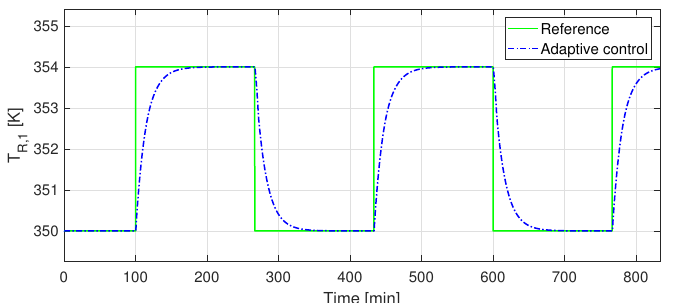
Figure 8. Performance of adaptive controller in presence of an abrupt change in temperature in reactor R 1 —output temperature T R ,1